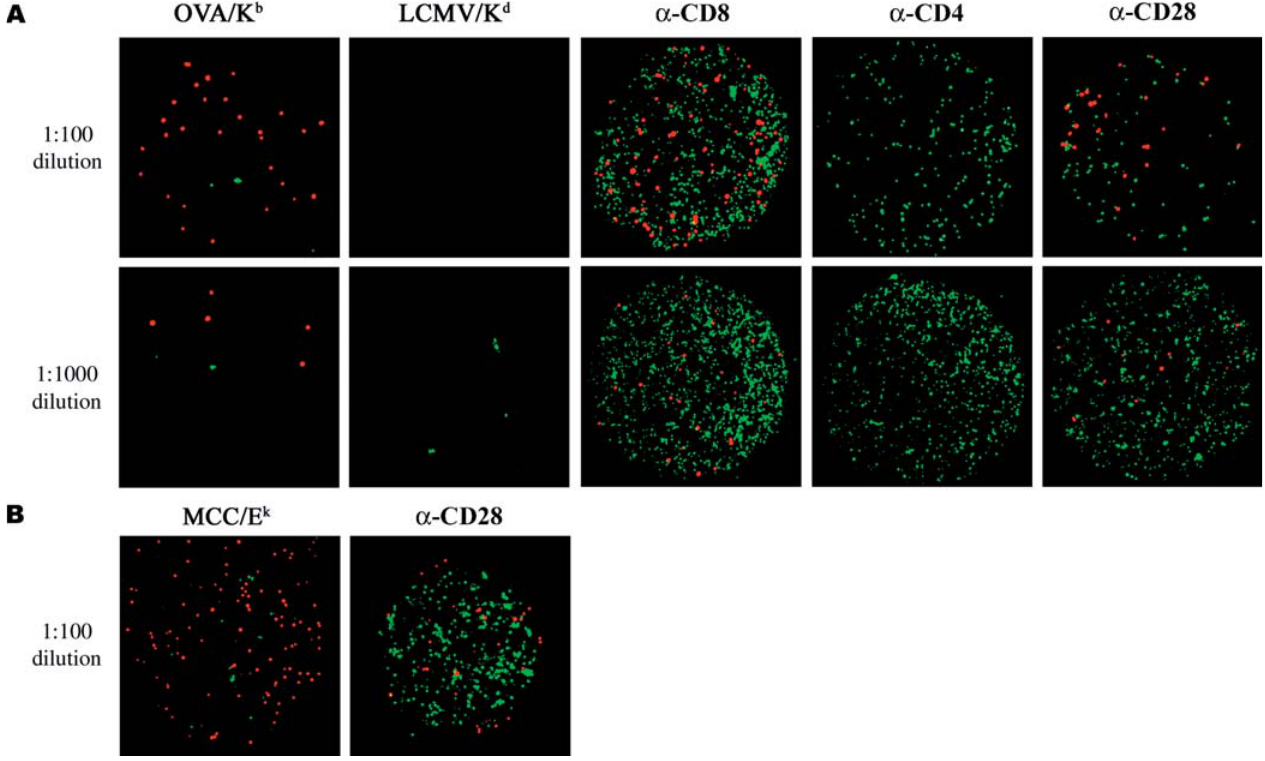
Figure 3. Sensitivity of Peptide–MHC Tetramer-Mediated Detection of OVA-Specific CTLs and MCC-Specific Helper T Cells (A) DiD-labeled OT-1 OVA-specific cells (red) were diluted 1:100 (top panels) or 1:1,000 (bottom panels) in DiO-labeled, monocyte-depleted C57BL/6 mouse lymph node cells (green). DiD-labeled OT-1 cells of 2.7 3 10 4 (top panels) and 4.41 3 10 3 (bottom panels) were mixed, respectively, with 2.7 3 10 6 and 4.41 3 10 6 of DiO-labeled CD11b-depleted lymph node cells. The different dilutions were applied to identical but separate arrays printed with the OVA/K b tetramer, the LCMV/K d control tetramer, and three different antibody spots (mouse anti-CD8, mouse anti-CD4, and mouse anti-CD28). Following 10-min incubation at 37 8 C, the cells were washed in RPMI and the slide was scanned. Shown are the OT-1 (red) and lymph node (green) cells that were captured by the OVA tetramer (left), LCMV tetramer (second left), and the antibody spots. (B) Class II MHC-mediated detection and sorting of helper T cells. DiD-labeled 5c.c7 lymphocytes (3.5 3 10 4 ) (red) were diluted 100-fold in 3.6 3 10 6 B10A DiO splenocytes (green). The mixed suspension was incubated at 37 8 C for 10 min prior to wash with RPMI. Shown are the 5c.c7 sells (red) and splenocytes (green) captured by the MCC (left) and anti-CD28 (right) spots. DOI: